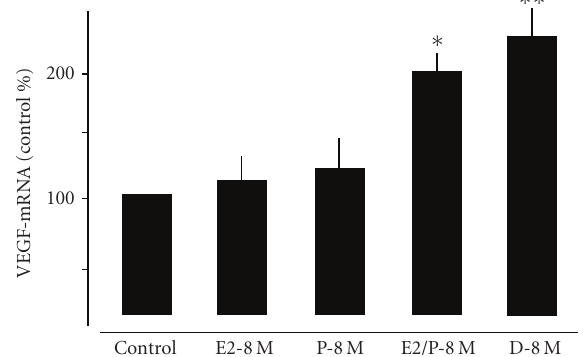
Figure 3: Quantitative analysis of VEGF gene expression in central lung fibroblasts treated for 48 hours with E2-8M and P-8M alone or in combination. Values were normalized against a housekeeping gene (HPRT) and expressed as % of controls. Note that only the combined application of both hormones significantly increased VEGF expression in central lung fibroblasts. Also note that the application of dexamethasone (D) had similar e ff ects on VEGF expression. ∗ P < . 01 control versus E2/P-8M, ∗∗ P < . 01 control versus D-8M.